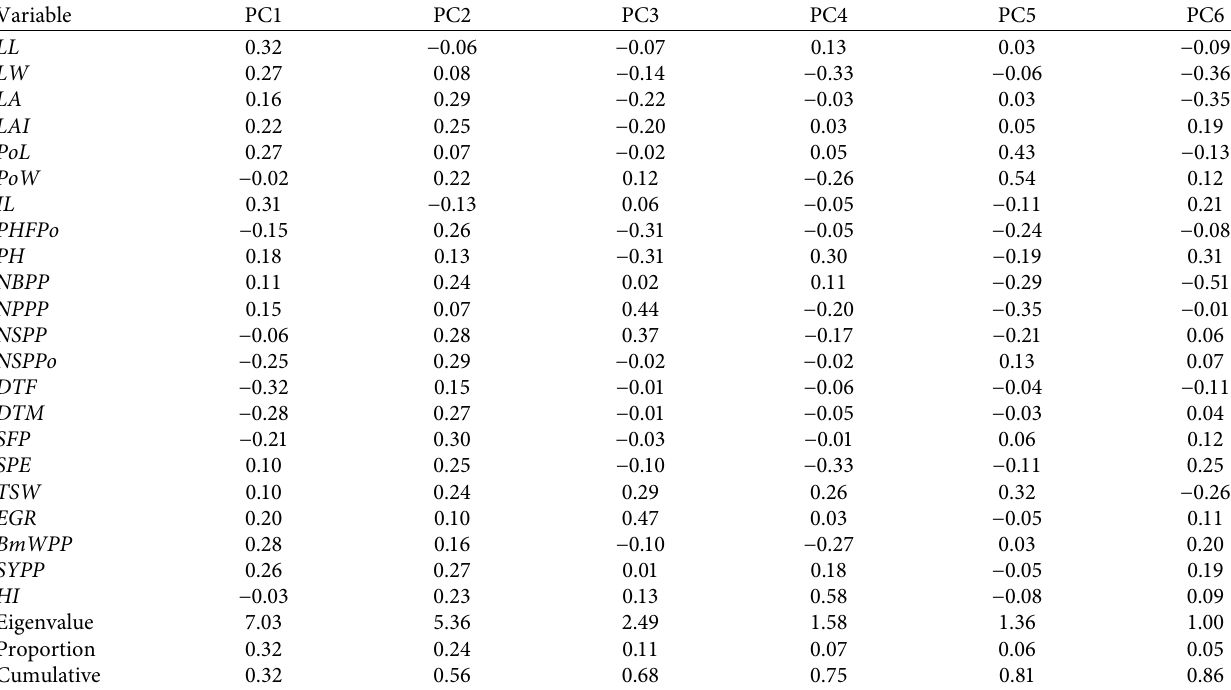
Table 10: Principal component’s analysis (PCA) for the 22 quantitative traits considered.